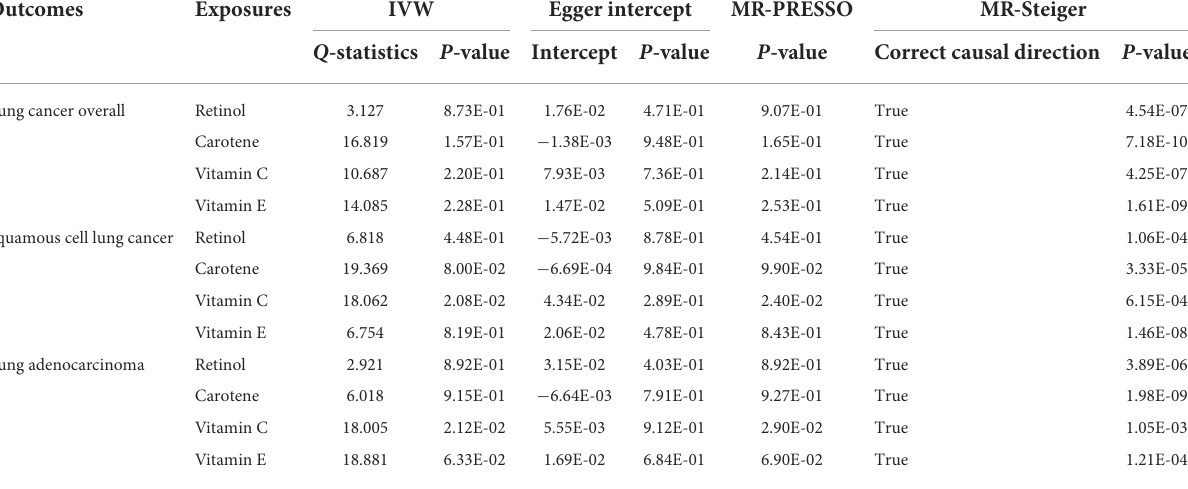
TABLE 2 The estimations of heterogeneity and horizontal pleiotropy for Mendelian randomization (MR) results. Outcomes